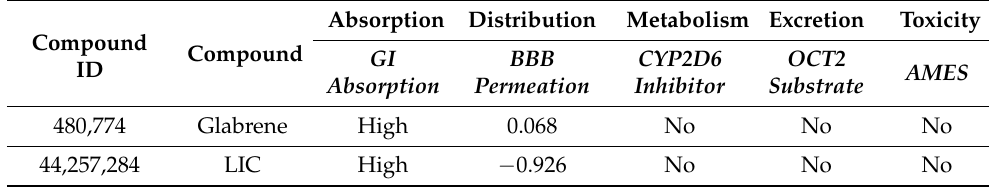
Table 2. ADMET properties of the elucidated